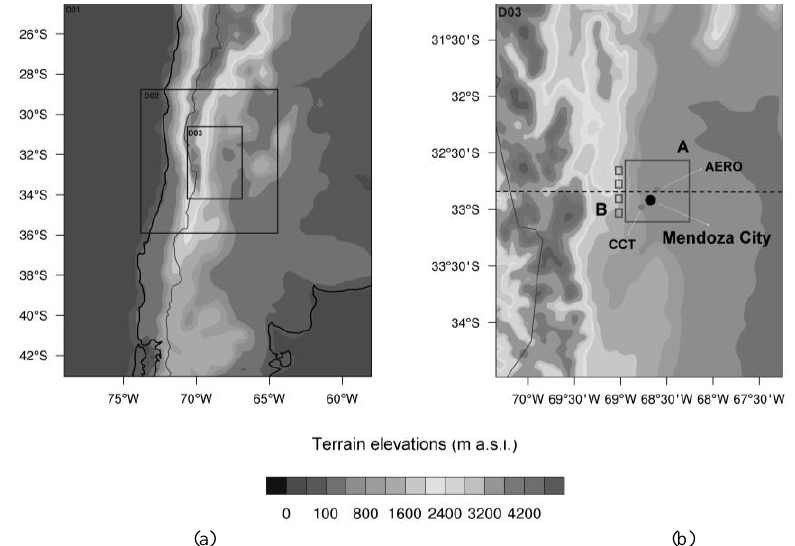
Fig. 1. Province of Mendoza, located in Western Argentina, and metropolitan area of Great Mendoza, located in the center- east of the Province of Mendoza: a) WRF/Chem-modelled nested domains, with the terrain heights in m a.s.l.: Domain D01 (36-km horizontal spatial resolution), Domain D02 (12-km horizontal spatial resolution), Domain D03 (4-km horizontal spatial resolution); b) Domain D03 enlarged, together with the distribution of the emission sources of tropospheric SO 42 − aerosols, according to configurations A and B. The black dot shows the location of the City of Mendoza (32  54' S, 68  51' W). The grey dots indicate the CCT (32  53' S, 68  52' W) and AERO (32  50' S, 68  48' W) weather stations. Dotted line: cross-sectional